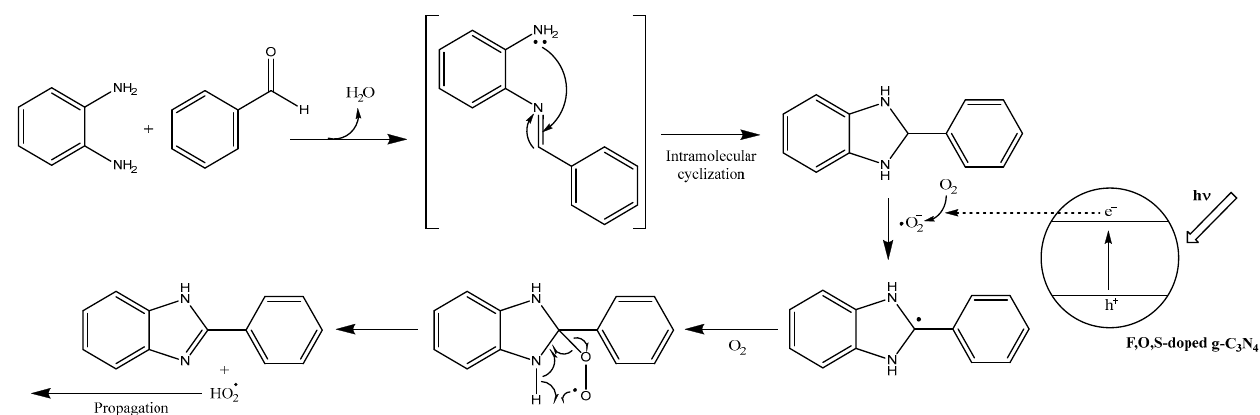
Figure 8. A possible reaction pathway for the formation of benzimidazole.